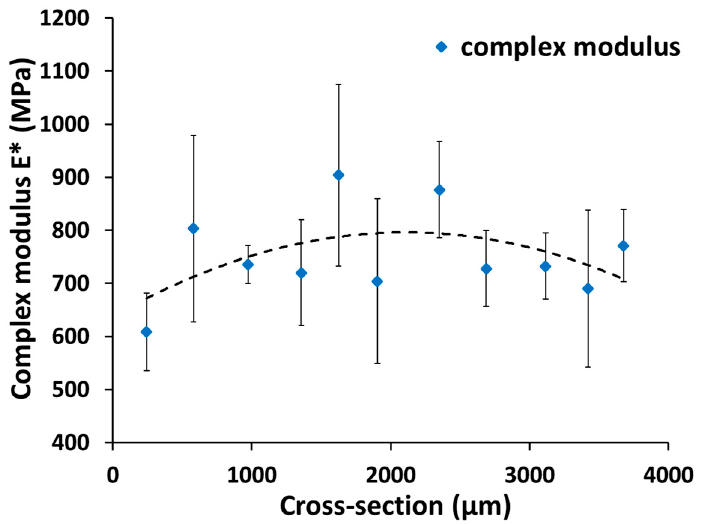
Figure 5. Complex modulus across the cross-section of unannealed HDPE; second order polynomial fit as a trend (dotted) line. as a trend (dotted)